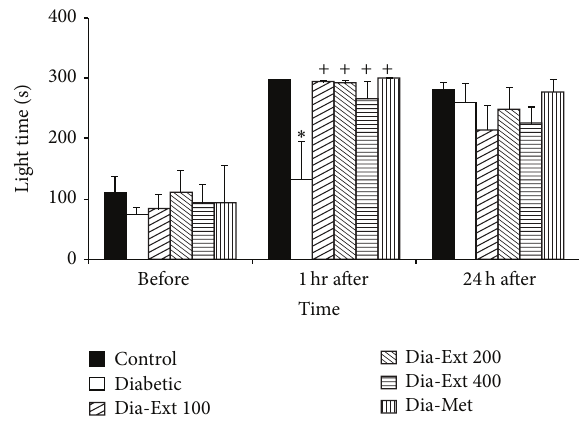
Figure 1: Comparison of time latency for entering the dark com- partment before and at 1 and 24 h after receiving the shock in the experimental groups. Data are presented as mean ± SEM ( 𝑛 = 10 in each group). ∗∗ 𝑃 < 0.01 in comparison with Control group and ++ 𝑃 < 0.01 and +++ 𝑃 < 0.001 in comparison with Diabetic group.